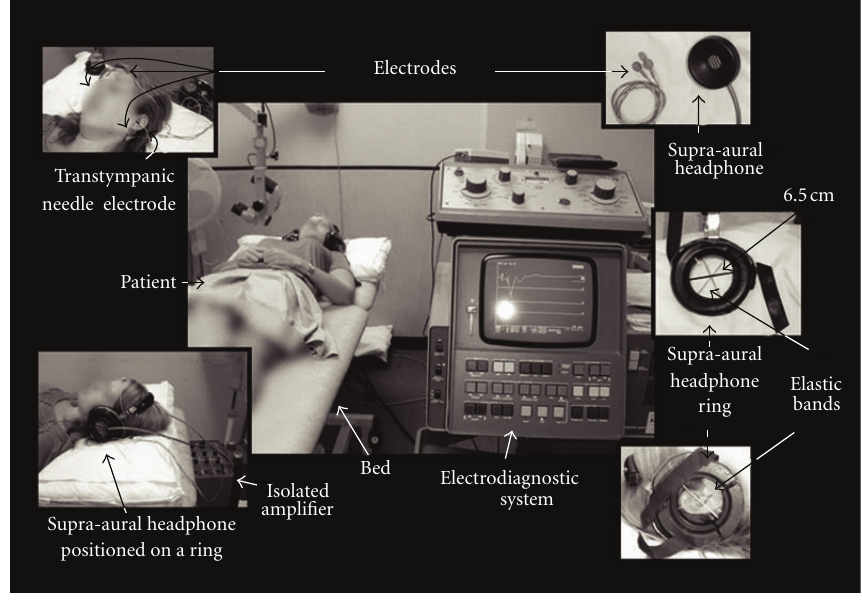
Figure 1: Instrumentation